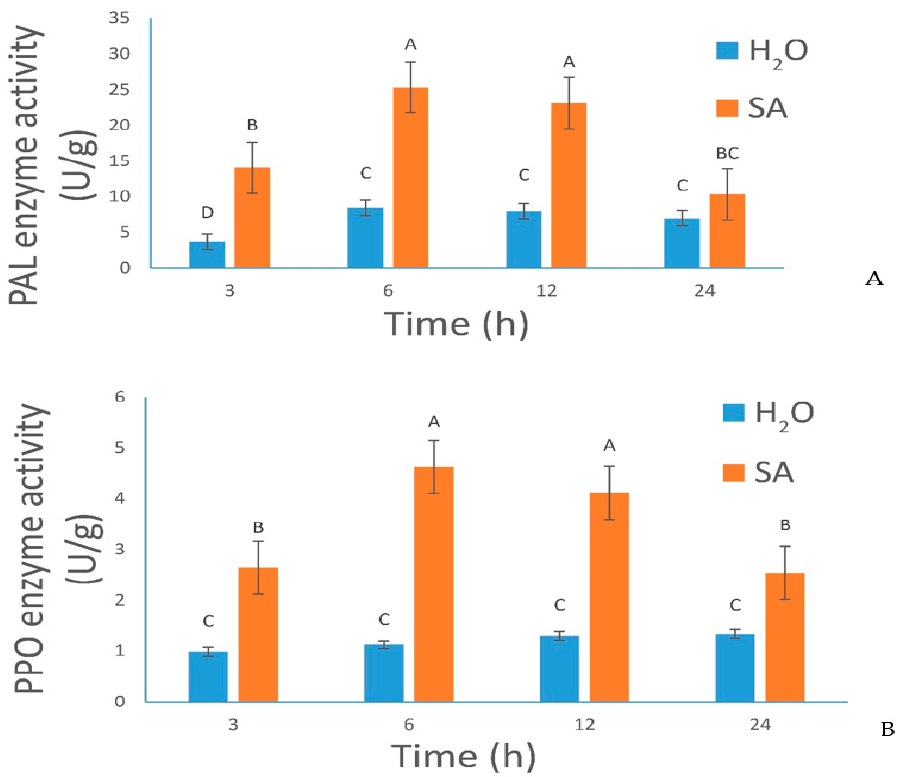
Figure 1. Effects of SA treatment on enzymatic activity. ( A ) and ( B ): Changes in phenylalanine ammonia-lyase (PAL) and polyphenol oxidase (PPO) activity in leaves at 3, 6, 12, and 24 h after treatments, respectively. Error bars indicate SDs among three biological replicates ( n = 3). Different letters indicate significant differences between SA-treated and untreated control samples. H 2 O, control samples; SA, SA-treated samples. Table 1. Statistical data of RNA-seq reads for the six libraries constructed from leaves treated with H 2 O and